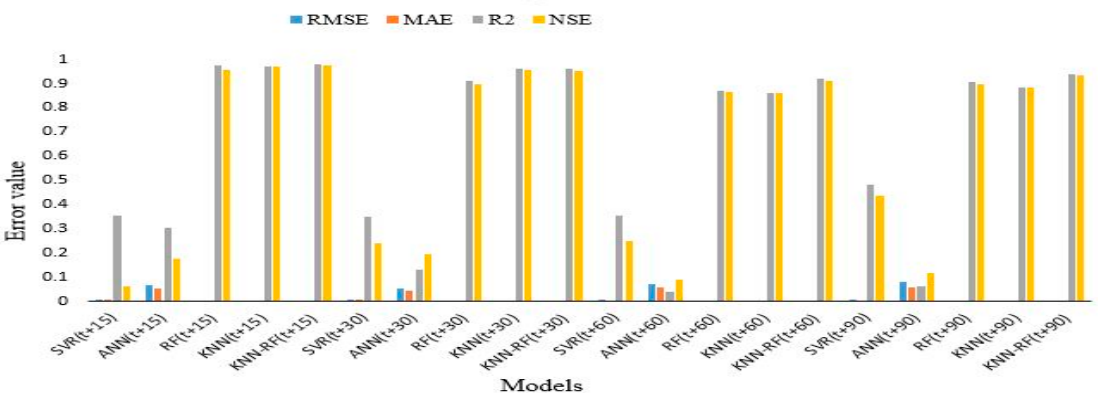
Figure 8. Comparison of the performance obtained by the SVR, ANN, RF, KNN, and KNN-RF models for 15, 30, 60, and 90 day-ahead groundwater level prediction.